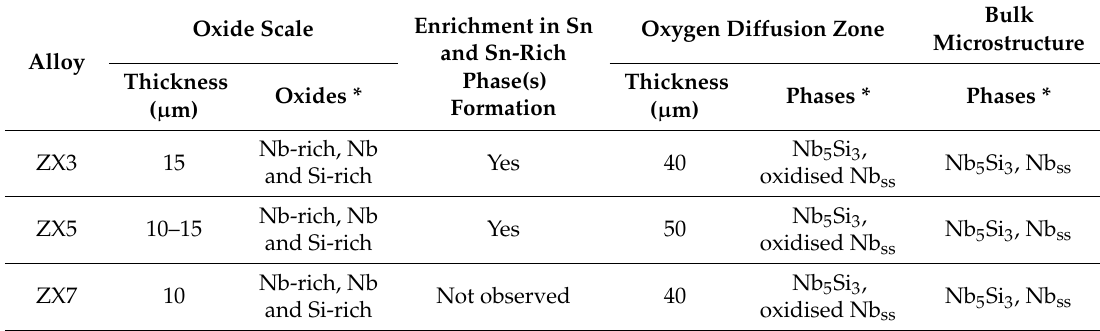
Table 3. Comparison of scales, diffusion zones, and bulk microstructures in the alloys at 800 ◦ C.